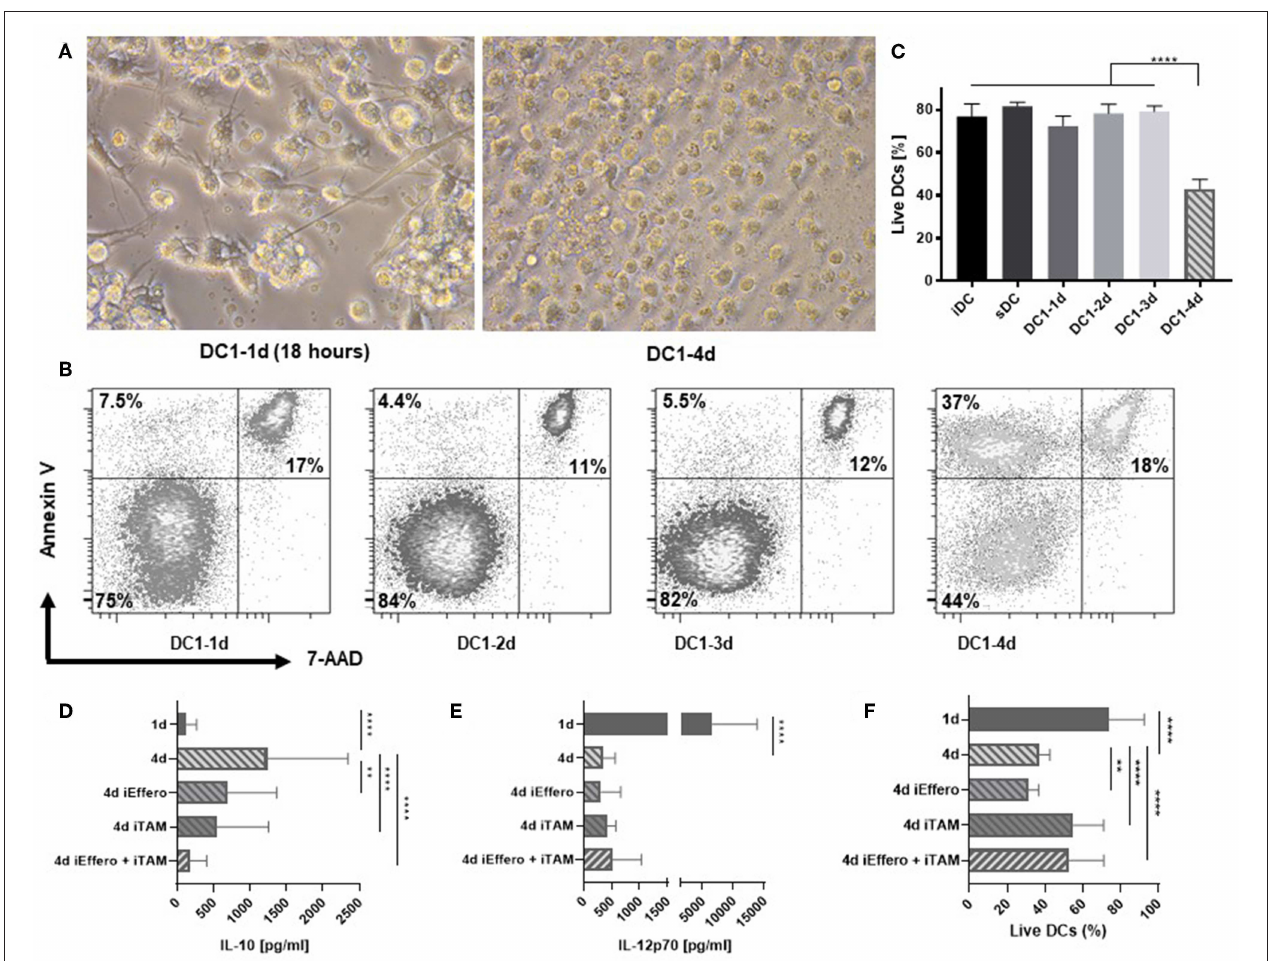
FIGURE 2 | Apoptosis is induced in DCs after 4 days of activation with LPS and IFN γ . (A) Morphology of 1- and 4-day activated DC1s (400X magnification). Four-day activated DC1s exhibit clear signs of undergoing apoptosis such as cell shrinkage and increased amounts of cell debris. Photographs are representative of six donors ( n = 6). (B) Apoptotic DCs were detected by staining with Annexin V and 7-AAD and percentages of live, pre-apoptotic, and dead cells is shown. The data is representative of three independent experiments with four donors ( n = 4). (C) Viability of DCs as a LIVE/DEAD Fixable Near-IR Stain negative percentage of FSC and SSC gated cells. Four-day activated DCs were cultured in the precense of specific inhibitors targeting TAM receptor signaling (iTAM) and/or efferocytosis (iEffero). (D) IL-10 and (E) IL-12p70 was measured in the supernatants and (F) the viability of DCs was measured with LIVE/DEAD Fixable dye. Cumulative data are shown from two independent experiments with four donors ( n = 4). Bars represent mean + standard deviation. Two-way ANOVA with Tukey’s post-hoc or Dunnett’s multiple comparisons test was performed on non-transformed data to compare groups (**** p ≤ 0.0001, ** p ≤ 0.01, and ns, not statistically